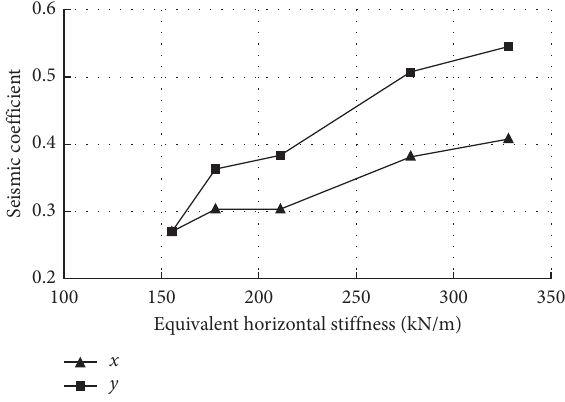
Figure 23: Seismic coefficient related to equivalent horizontal stiffness.